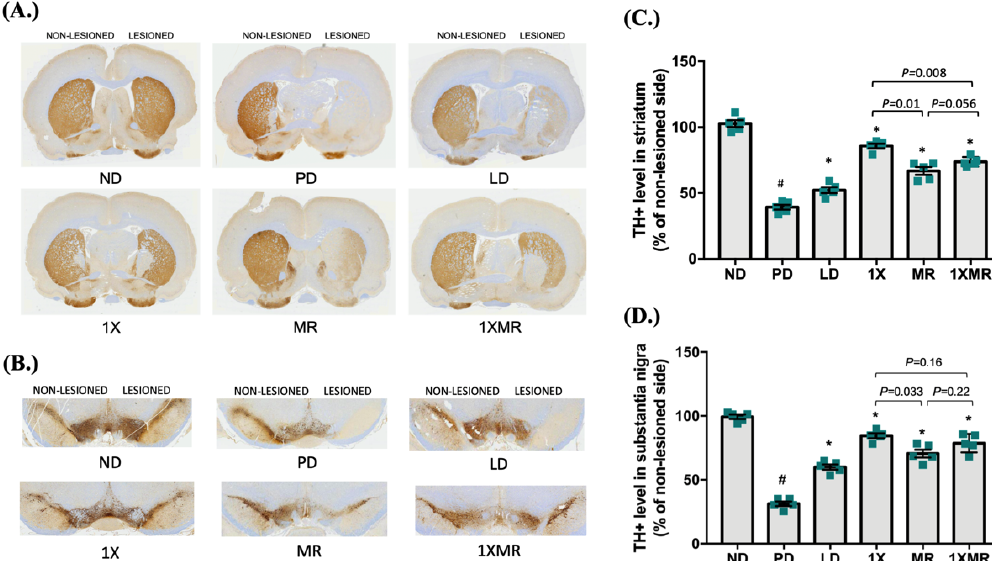
Figure 2. Evaluation of dopaminergic neurons in the striatum and substantia nigra pars compacta (SNpc) after 8 weeks of treatment. ( A ) Immunohistochemical staining for tyrosine hydroxylase (TH) was performed to identify dopaminergic neurons in the striatum. ( B ) Immunohistochemical staining of TH in the SNpc region. ( C ) Quantification of TH-positive (TH+) cells in the striatum. ( D ) Quantification of TH-positive cells in the SNpc region. TH staining intensity is normalized to the non-lesioned side and expressed as mean ± SEM ( n = 5 rats/group). Significant differences (bars) are expressed as p < 0.05. One-way ANOVA with Tukey’s post hoc test; # p < 0.05 for comparison of the PD group with the ND group; * p < 0.05 for comparison of LD, 1X, MR, and 1XMR groups with the PD group. ND, non-diseased; PD, untreated PD; LD, PD treated with 8 mg of L-DOPA; 1X, PD supplemented with the probiotic; MR, PD supplemented with MR as prebiotic; 1XMR, PD supplemented with a combination of 1X and MR.